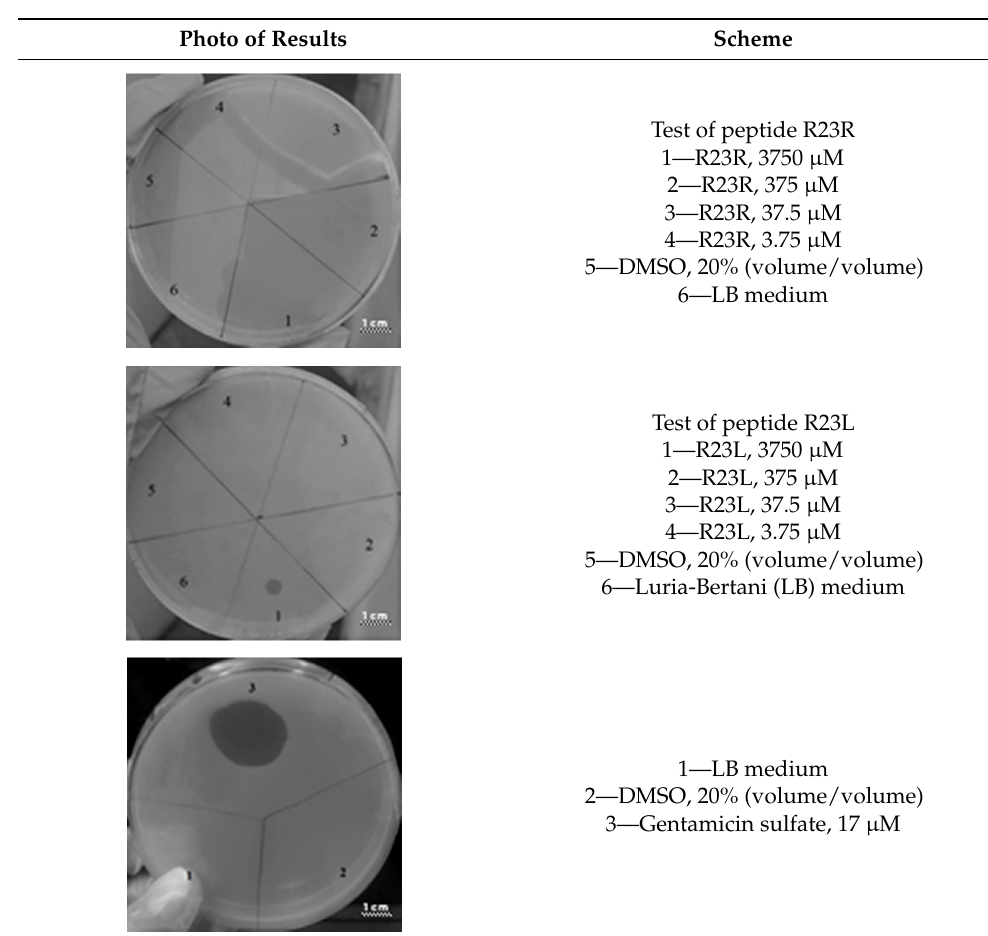
Table 4. Results of testing the antimicrobial properties of the R23R, R23L, R23R*, and R23L* peptides with the P. aeruginosa (strain ATCC 9027) cells. The scale bar is 1 cm.